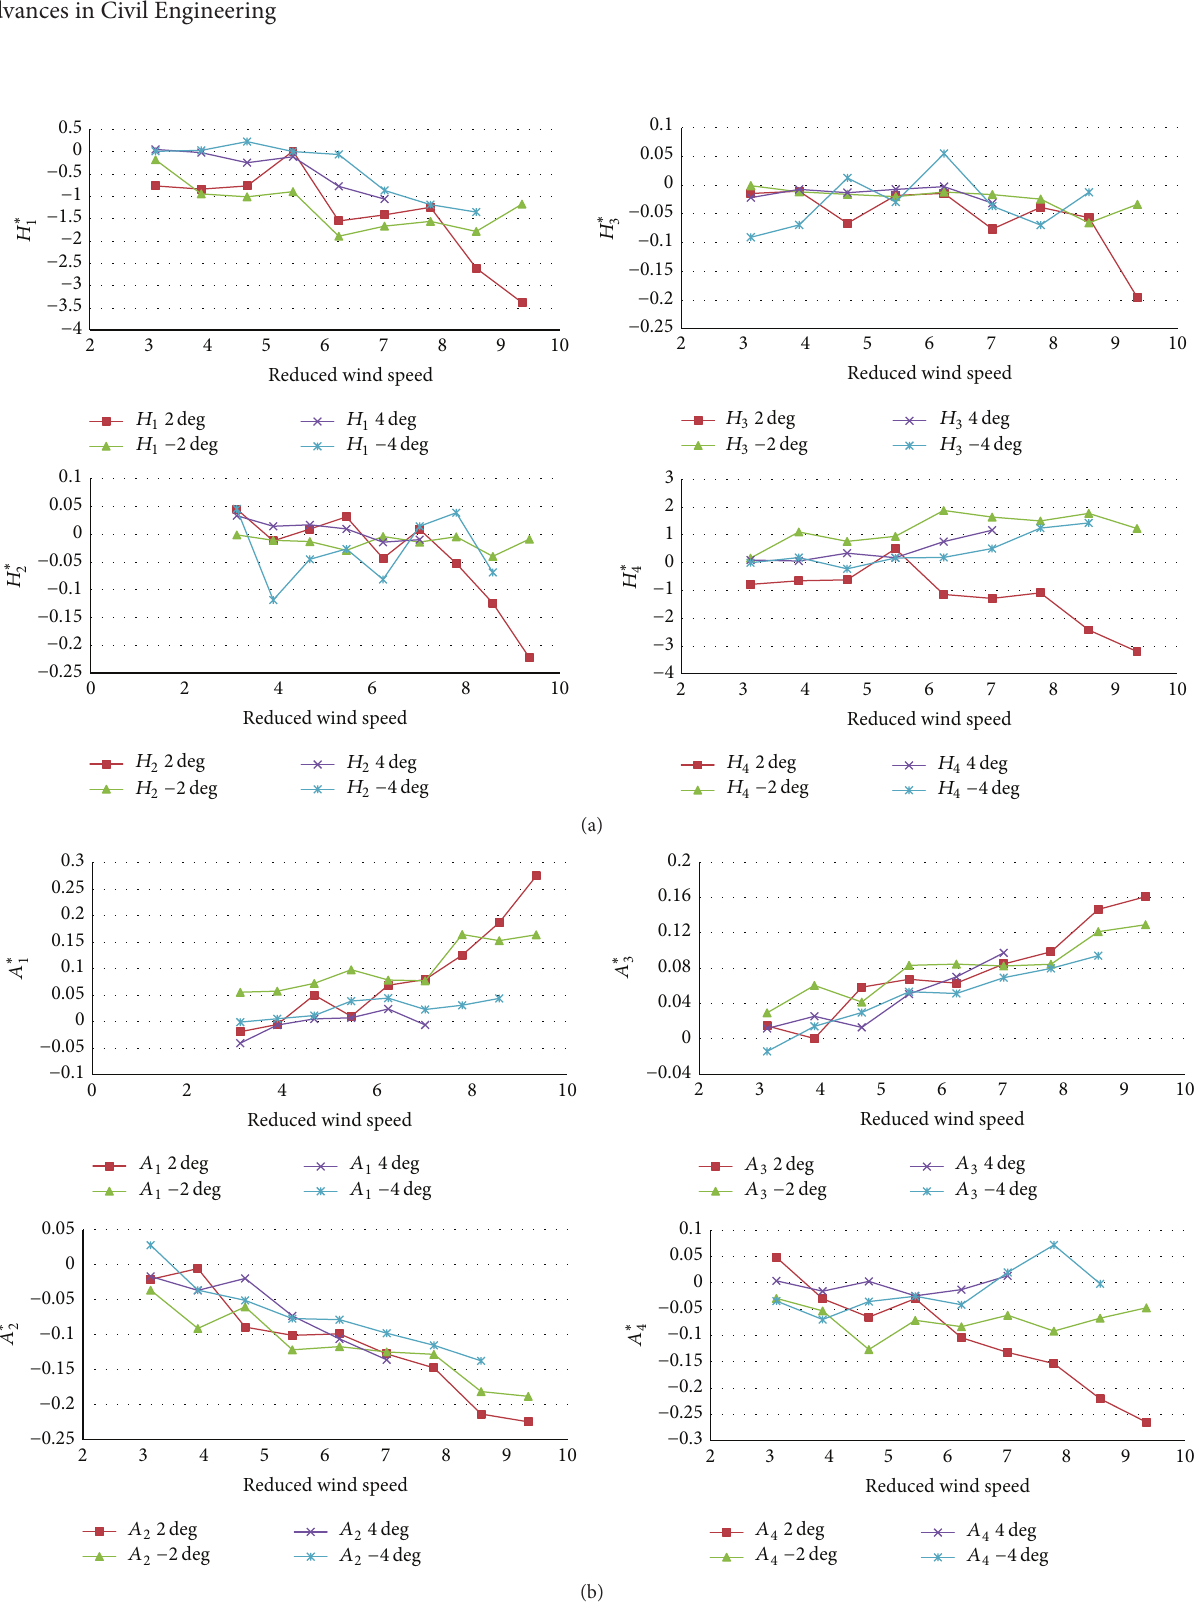
Figure 9: (a) Flutter derivatives 𝐻 ∗ 1 , 𝐻 ∗ 2 , 𝐻 ∗ 3 , and 𝐻 ∗ 4 for the multibox bridge deck for angles of attack of − 4 ∘ , − 2 ∘ , 2 ∘ , and 4 ∘ . (b) Flutter derivatives 𝐴 ∗ 1 , 𝐴 ∗ 2 , 𝐴 ∗ 3 , and 𝐴 ∗ 4 for the multibox bridge deck for angles of attack of − 4 ∘ , − 2 ∘ , 2 ∘ , and 4 ∘